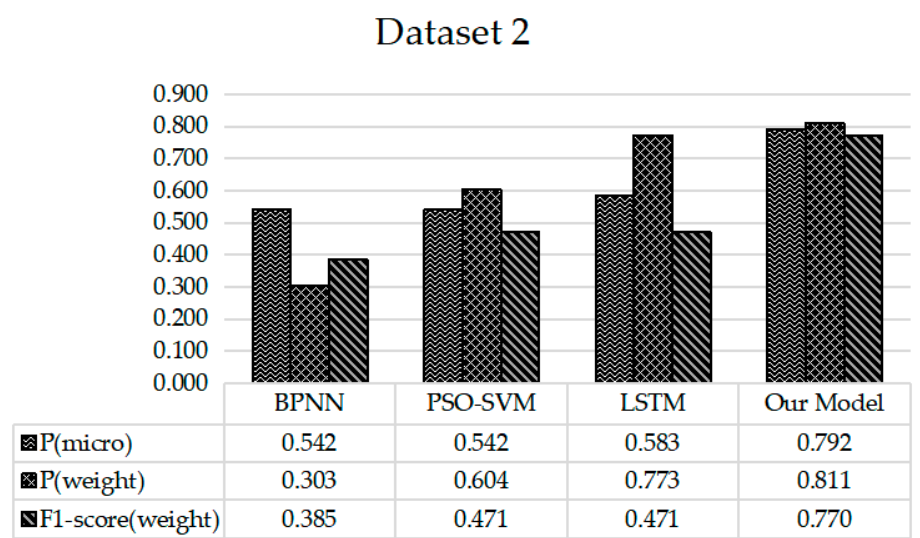
Figure 7. Results of popularity trend prediction on dataset 1.